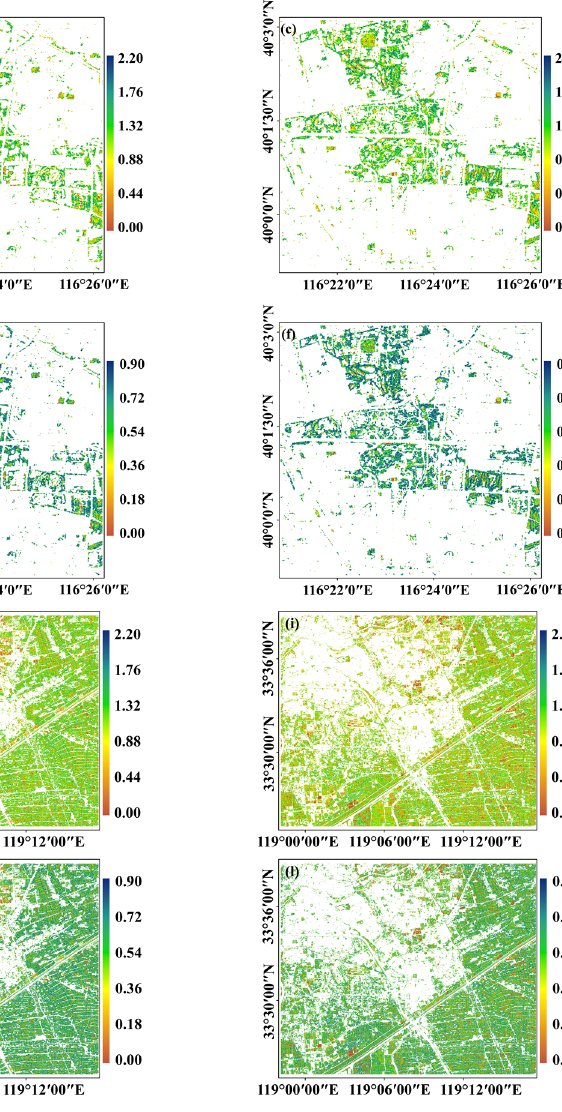
Figure 5. Spatial distribution of ShDI and SiDI based on Sentinel-2 data where ( a – c ) are ShDIs in Case I on 28 August 2016, 5 September 2018, and 19 September 2020, respectively; ( d – f ) are SiDIs in Case I on those days; ( g – i ) are ShDIs in Case II